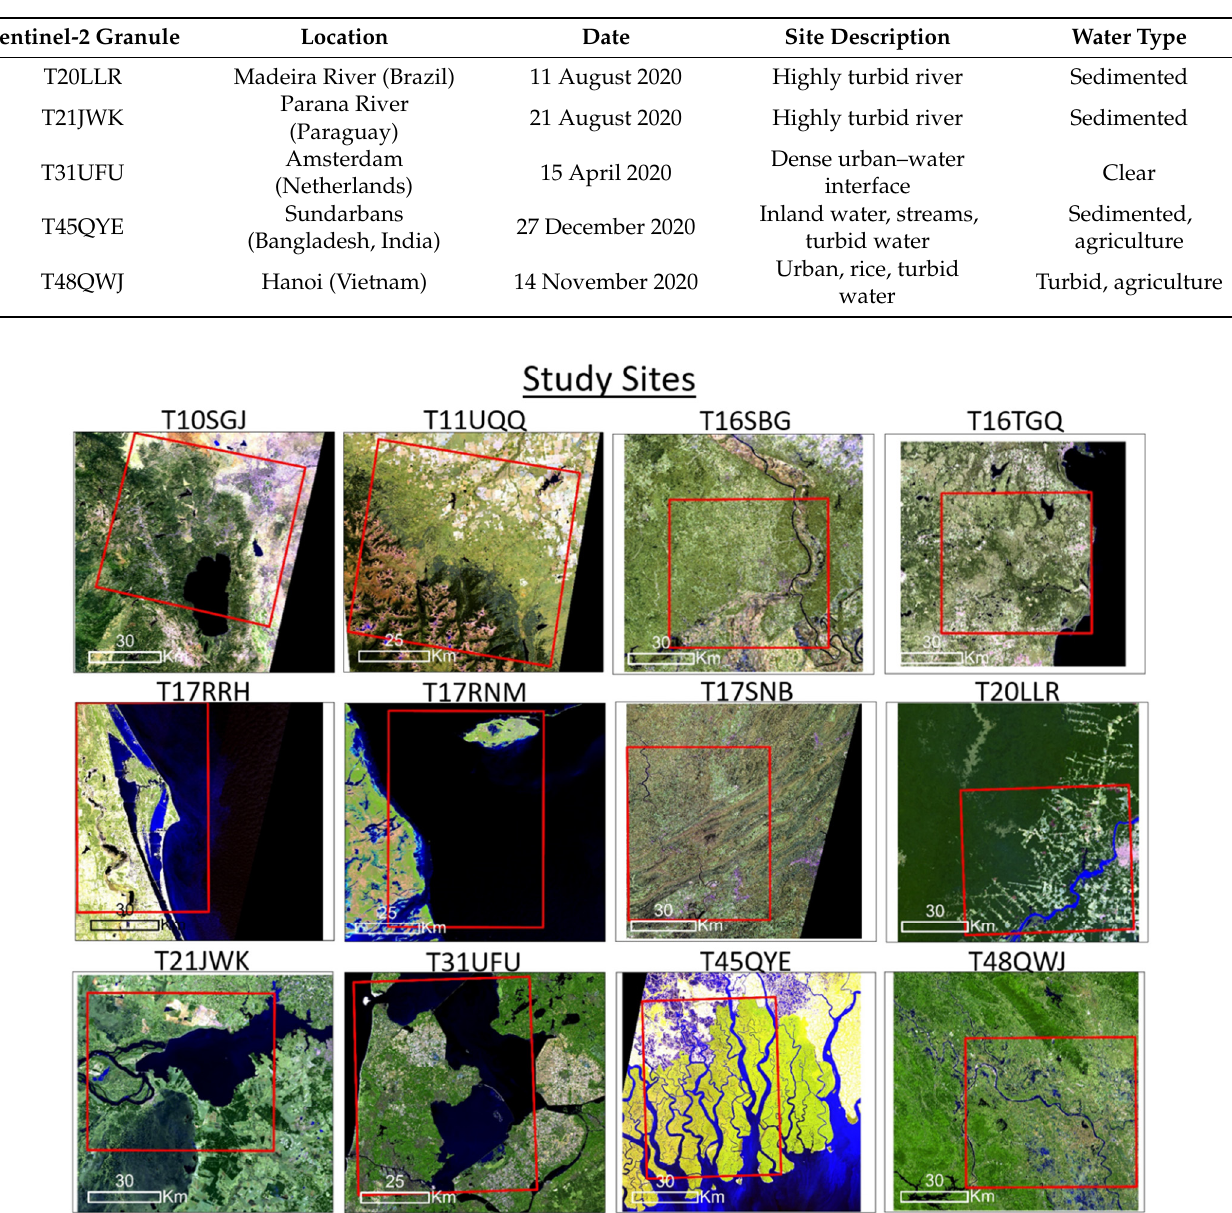
Figure 1. Overview of the twelve study sites shown in red outline. Each granule is visualized with Red, Green, Blue (RGB) channel bands of: SWIR1, Near-IR, and Red with varied histogram stretches and slightly varied zoom levels. Each study area is approximately 5000 km 2 .